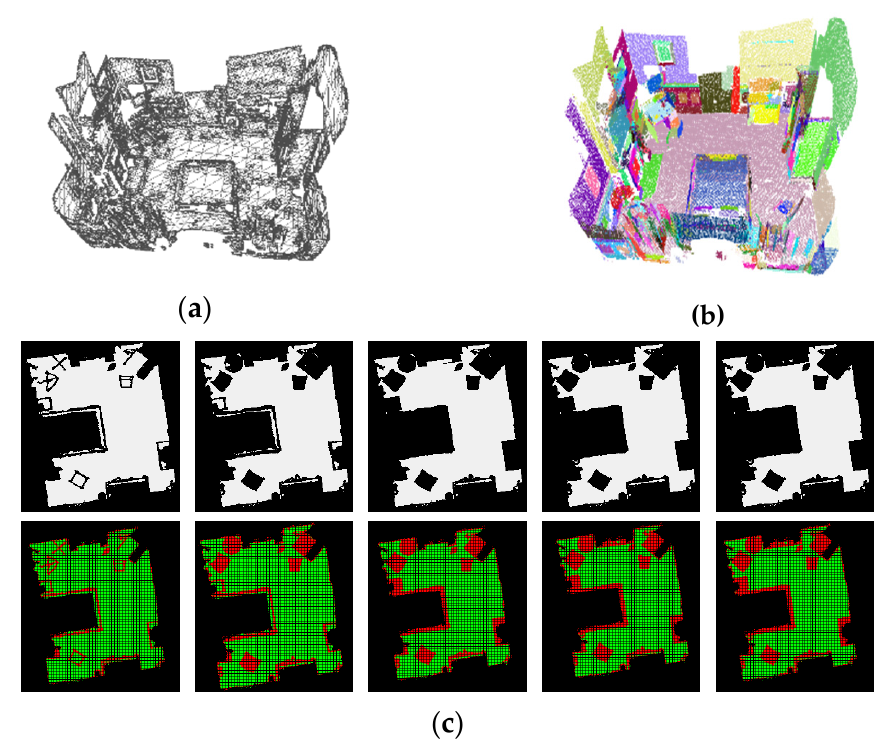
Figure 21. ISE result of real dataset 3: ( a ) FSM result, ( b ) original planar point cloud, and ( c ) PAM.